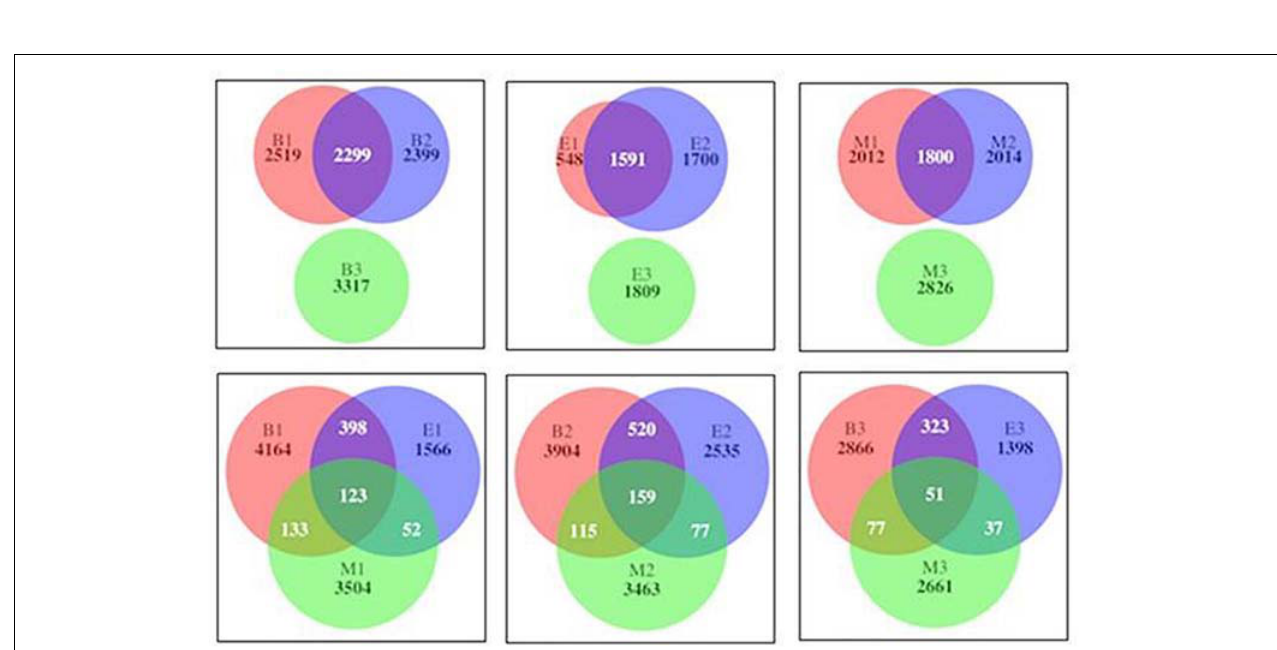
FIGURE 11 | Fourteen most abundant genera, detected by three universal prokaryote primers in each wetland. The remaining taxa with lower abundance are classified into “Other.” The abbreviations and numerics used are as follows: B, Bhomra; E, EKW; M, Malencho; 1, 341b4_F/806_R; 2, N341b4_F/806_R; 3, Pro341F/Pro805R; EKW, East Kolkata wetland.